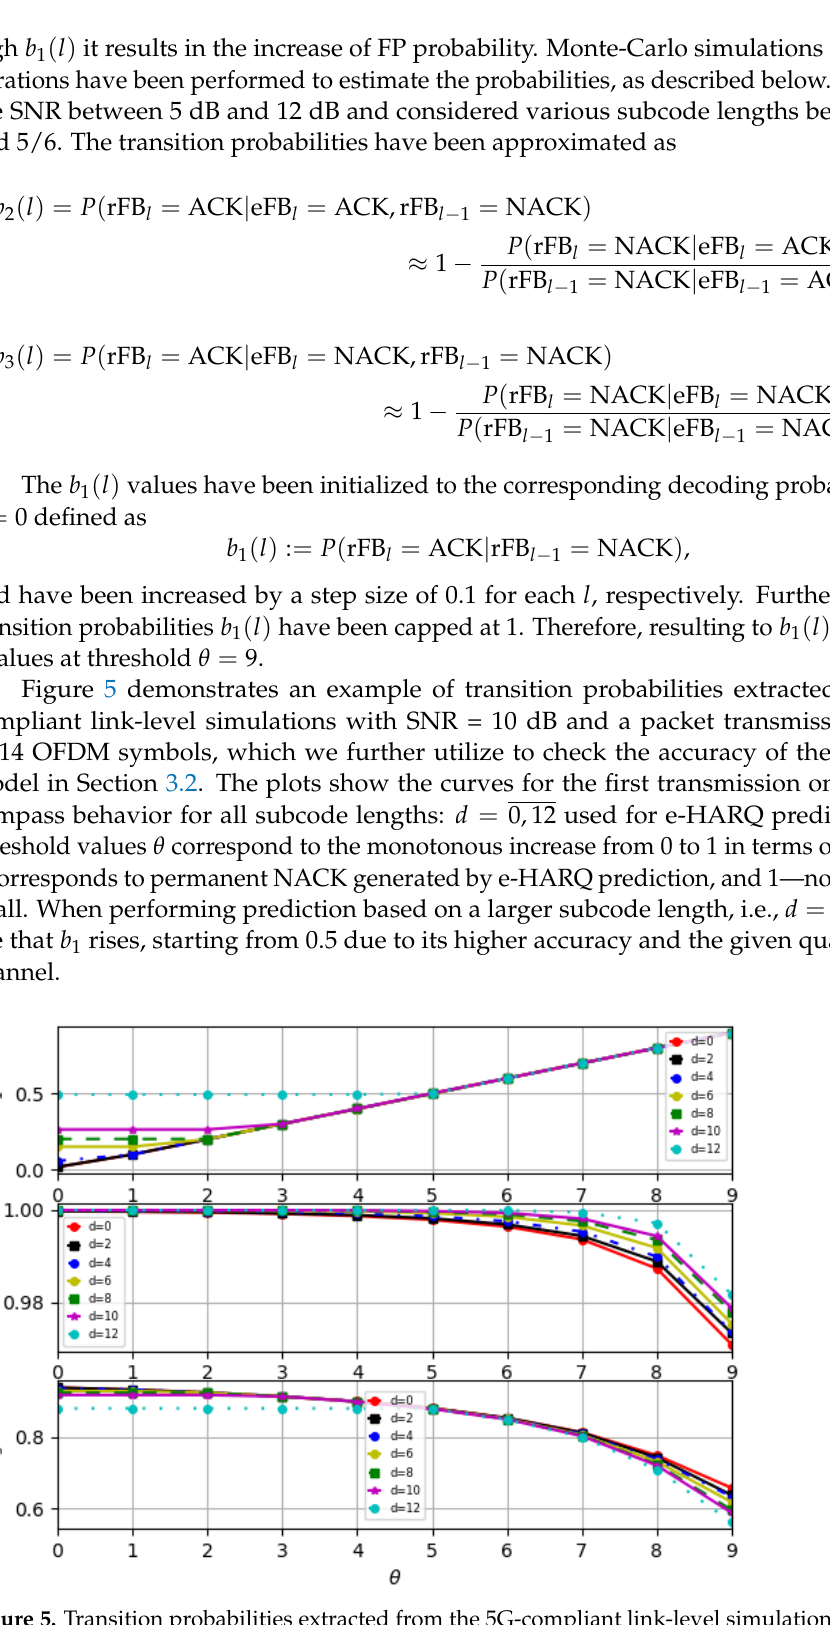
Figure 5. Transition probabilities extracted from the 5G-compliant link-level